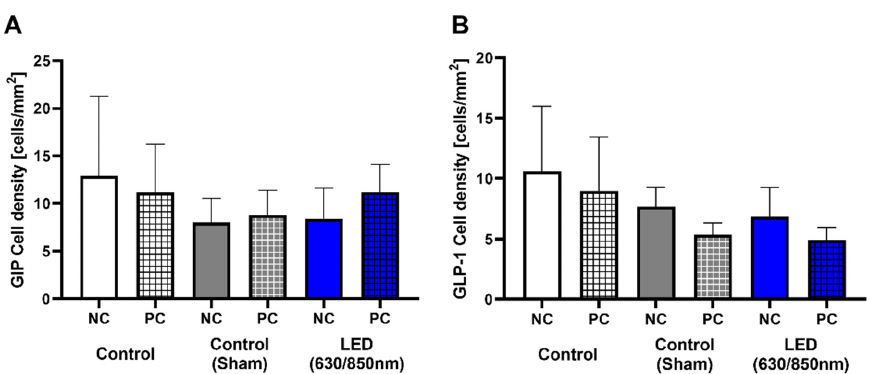
Figure 4. Quantitative measurement of the difference in the expression of ( A ) glucose-dependent insulinotropic polypeptide (GIP) and ( B ) glucagon-like peptide 1 (GLP-1) in duodenal villi, which separately sampled two regions of the duodenum. PC (positive treated tissue) and NC (negative treated tissue) are sampled from duodenum tissue among the control, sham control, and D-PBM (630/850 nm) groups.